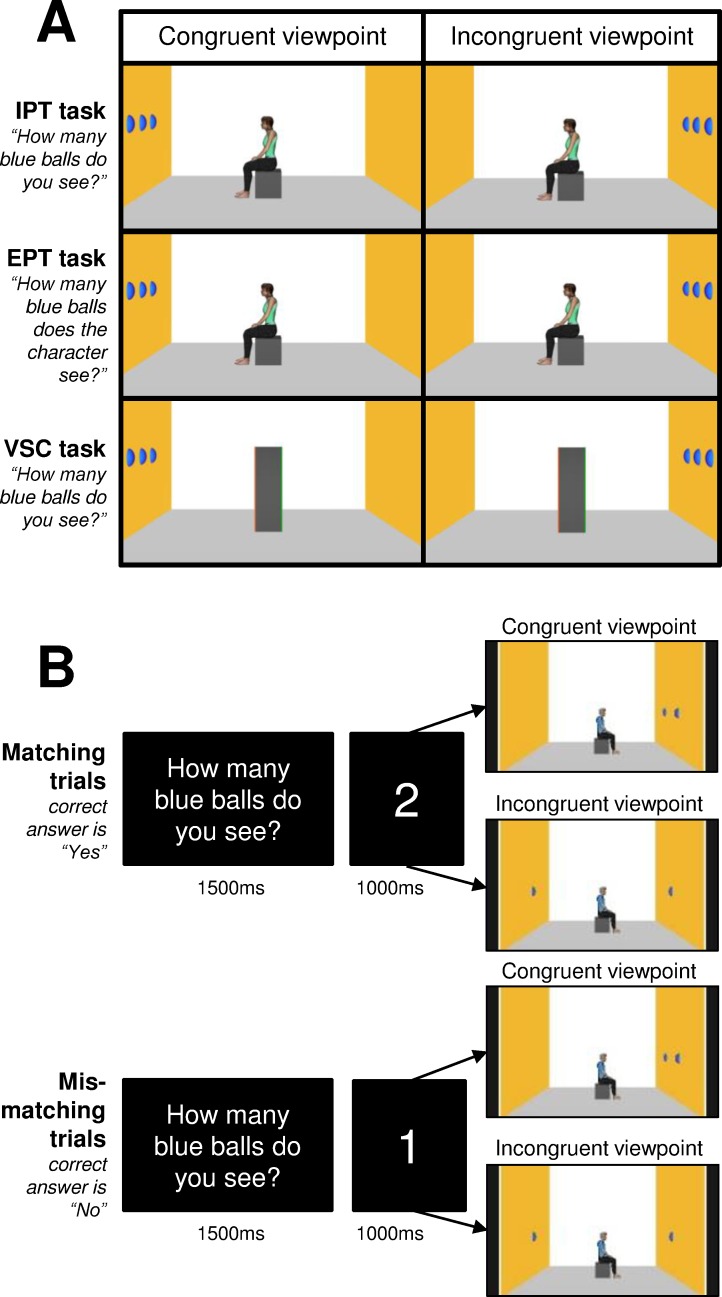
Methods for visuo-spatial perspective-taking tasks (Experiment 1).(A) Examples of visual stimuli used for the tasks of implicit perspective taking (IPT), explicit perspective taking (EPT) task, and visuo-spatial control (VSC) task. Visual stimuli presented a congruent or an incongruent viewpoint of the avatar with the participant’s viewpoint. (B) Participants indicated whether the number of balls seen from their viewpoint (IPT and VSC tasks) matched (i.e., matching trials) or did not match (i.e., mismatching trials) the number presented in the instruction.